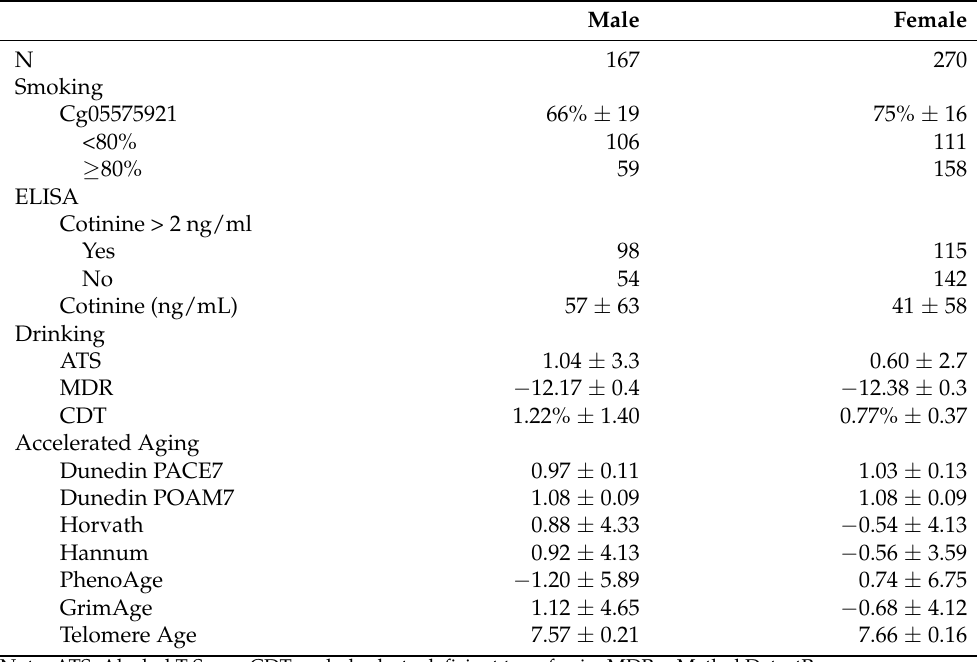
Table 2. Indices of Epigenetic Aging and Alcohol Use at Wave